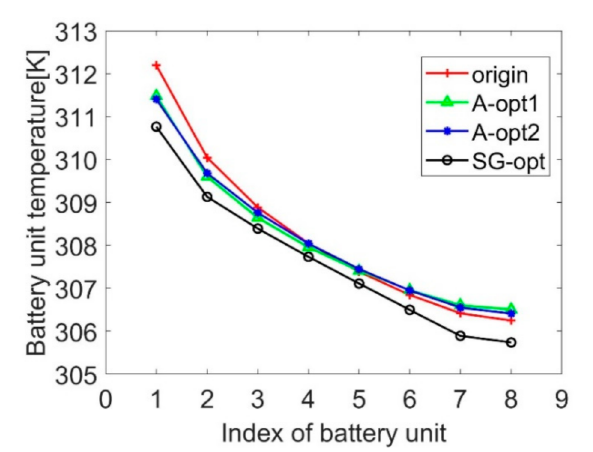
Figure 15. Comparison of the battery unit temperature before and after optimization.